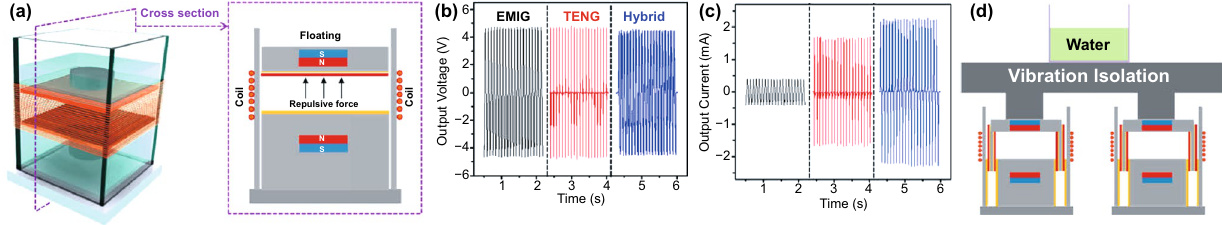
Fig. 15 a Schematic diagram of the unidirectional hybrid cell integrated with a contact-mode TENG and EMG developed by Hu et al. and cross section view. After impedance match, b output voltage and c output current of the EMG/EMIG, TENG and hybrid cell (parallel connected EMG and TENG) on a load of 5 kΩ. d Diagram of the construction of the hybrid cell working as a both a vibration isolator and energy harvester. Reproduced with permission from Ref. [47]. Copyright 2014, American Chemical Society. (Color figure